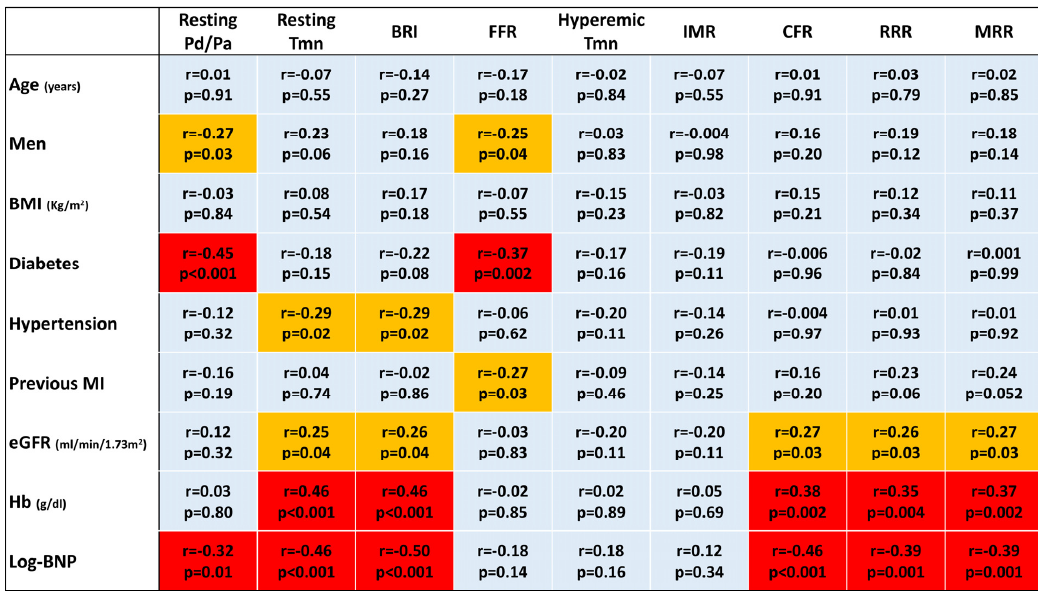
Figure 5. The receiver operating characteristic curve analyses of RRR and MRR for CMD in cases in which papaverine was used as a hyperemic agent. AUC, area under the curve; CMD, coronary microvascular dysfunction; MRR, microvascular resistance reserve, RRR; resistance reserve ratio.